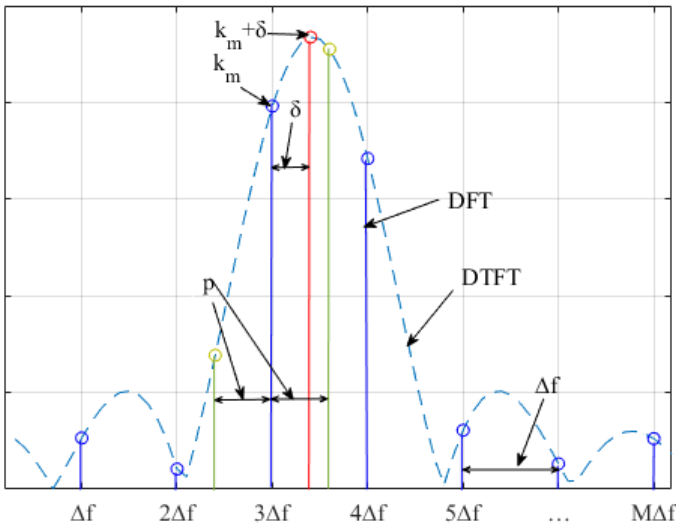
Figure 1. Magnitudes of the DTFT and DFT of a complex exponential